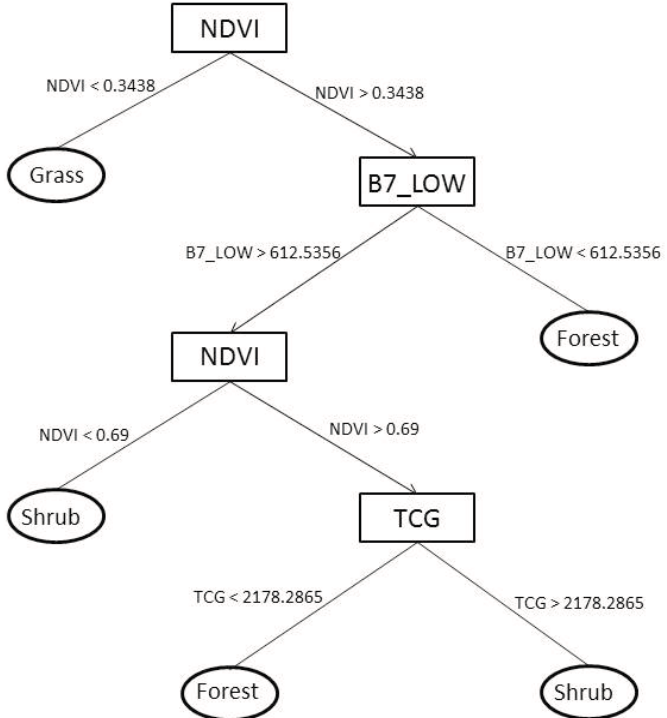
Figure 2. Classification tree developed for the 2012 base year that was applied to all years.